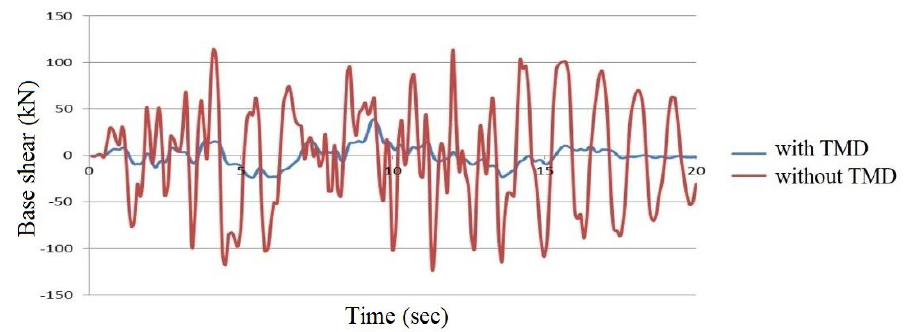
Figure 22. Comparison of the base shear obtained by the nonlinear time-history analysis when the structure remains within the elastic range.